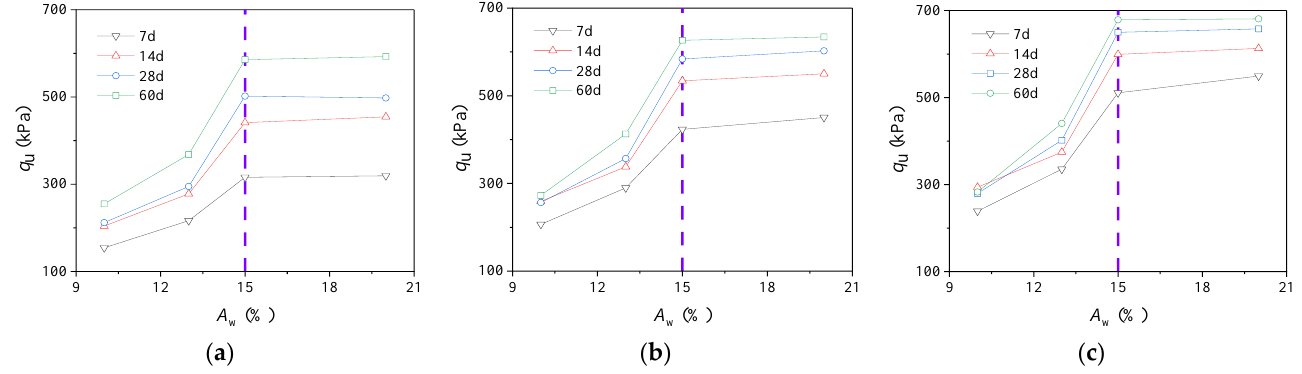
Figure 5. Relationship of q u - A w with C o = 7.7% at different T . ( a ) T = 18 °C ; ( b ) T = 36 °C ; ( c ) T = 46 °C .